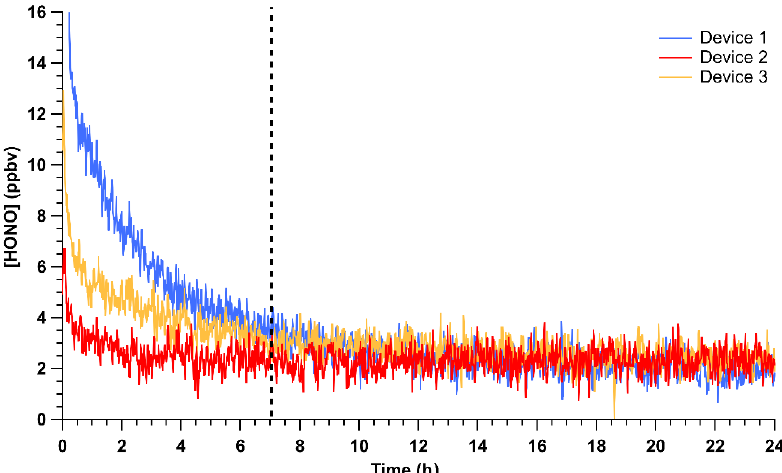
Figure 3. Mixing ratios of HONO observed using HCl PD-6a and three different, but freshly coated, NaNO 2 PFA reaction devices. Time zero indicates the start of HONO production in the calibration unit where no prior flow through the calibration unit existed, but all temperatures were stable at 40 ◦ C. The vertical dashed line denotes the time where the outputs of the three devices are no longer statistically different from each other. Reported measurements are 1min average data with a 30s Kalman filter on the NO x